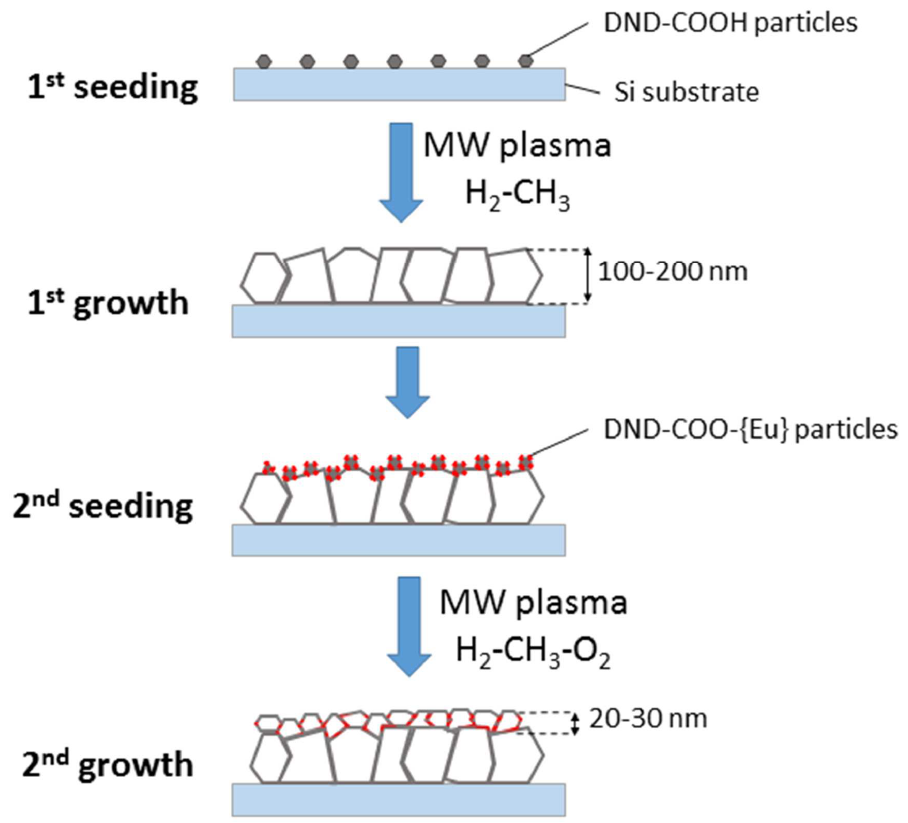
Figure 2. Scheme for synthesis of CVD diamond film doped with Eu.